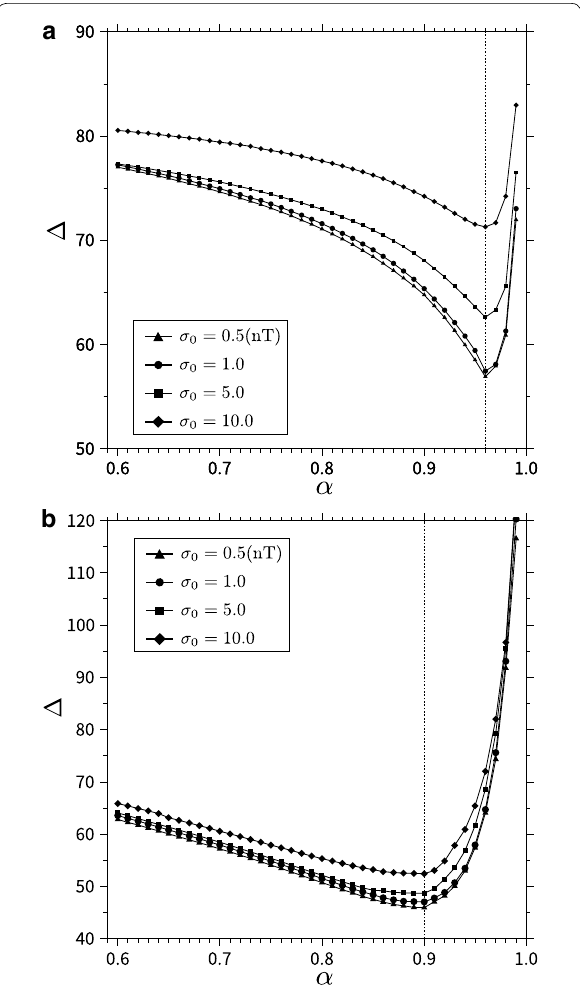
Fig. 16 Plot of (cid:31) for α . Plot of (cid:31) for α in the range of 0.60 to 0.99 with an interval of 0.01, using the weighting function of a w S 1 , and b w S 2 . The solid triangles, circles, squares, and diamonds indicate the case of σ 0 0.5,1.0,5.0 , and 10.0 nT, = 0km profile =